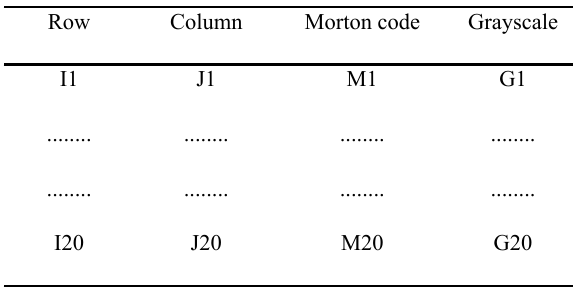
Use the Morton code to represent the row number column number of each grid. The obtained data structure is shown